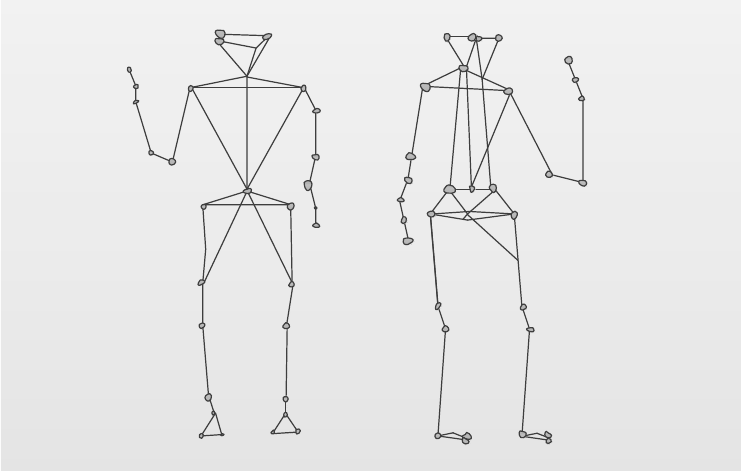
Figure 3. Right hand waving in different positions.